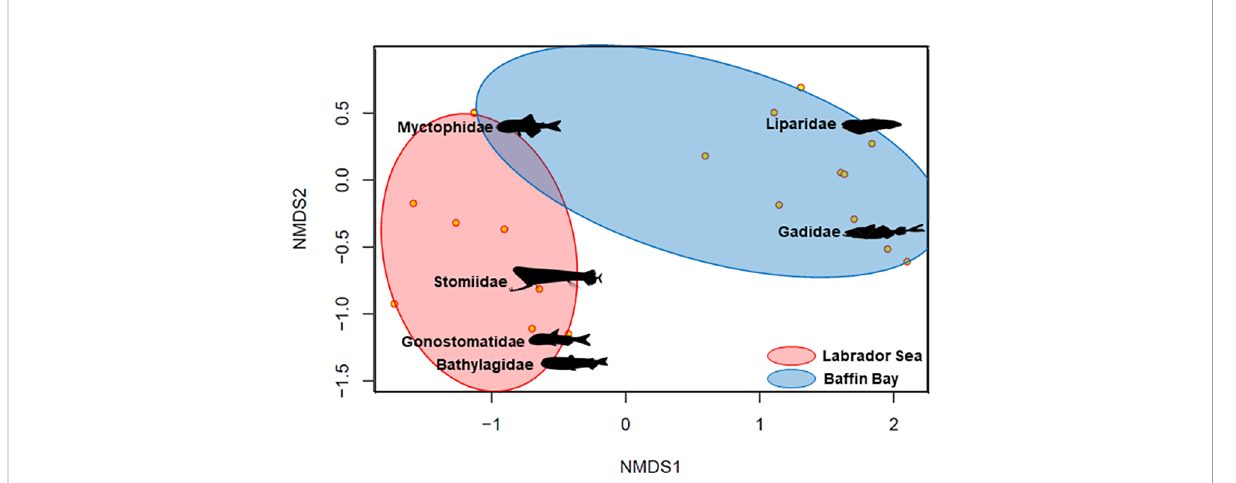
FIGURE 2 Family-level fi sh community response across the West Greenland Polar Front in the Canadian Arctic. Ordination plot using non-metric multidimensional scaling (nMDS, stress=0.057) of IKMT adult fi sh captured in the Canadian Arctic. Each sample (yellow) represent an individual site. Colored ellipses are computed to enclose all points along the boundary of groups representing fi sh families found in the Labrador Sea (red) and Baf fi n Bay (blue). Families (and representative images) are plotted as centroids and are computed as the weighted average scores in the ordination